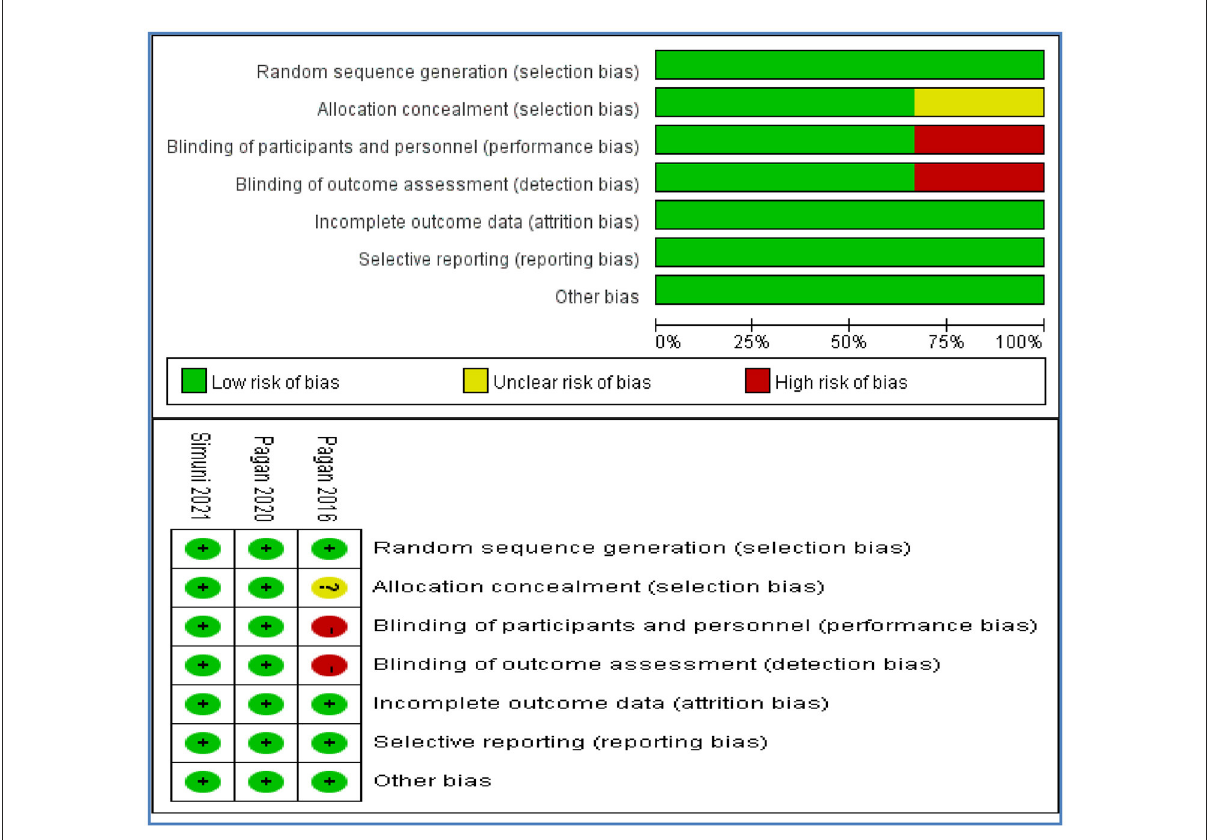
FIGURE2 Risk of bias